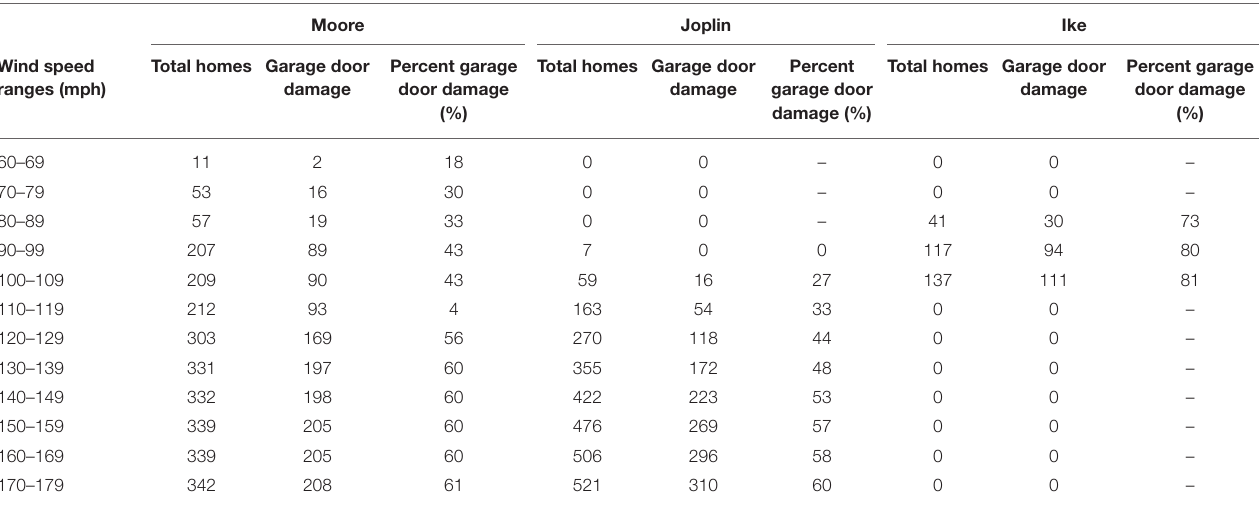
TABLE 2 | Cumulative garage door damage by wind speed.